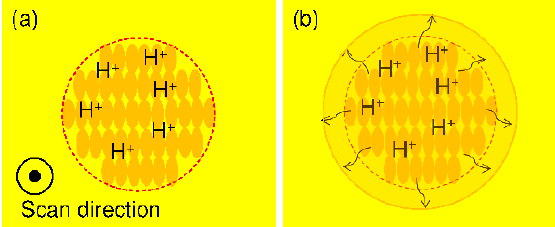
Figure 4. Mechanism for producing a smooth mold surface when using a chemically amplified resist. ( a ) Acid generation after femtosecond laser exposure; ( b ) Acid diffusion during post-exposure bake.